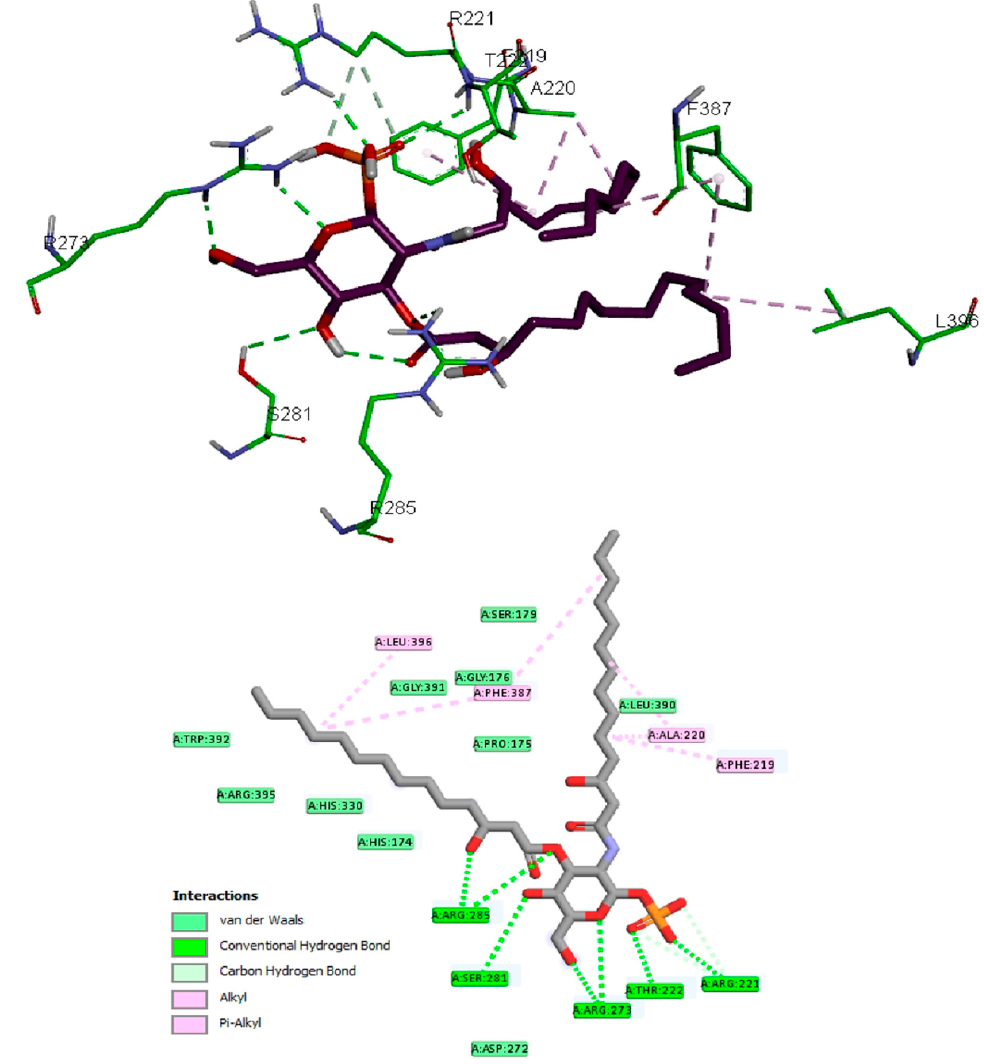
Figure 4. Docking of LAM in K. pneumoniae lipid A core-O-antigen ligase (LAL); active site view ( Top ) and the 2D schematic presentation of interaction forces ( Bottom ).